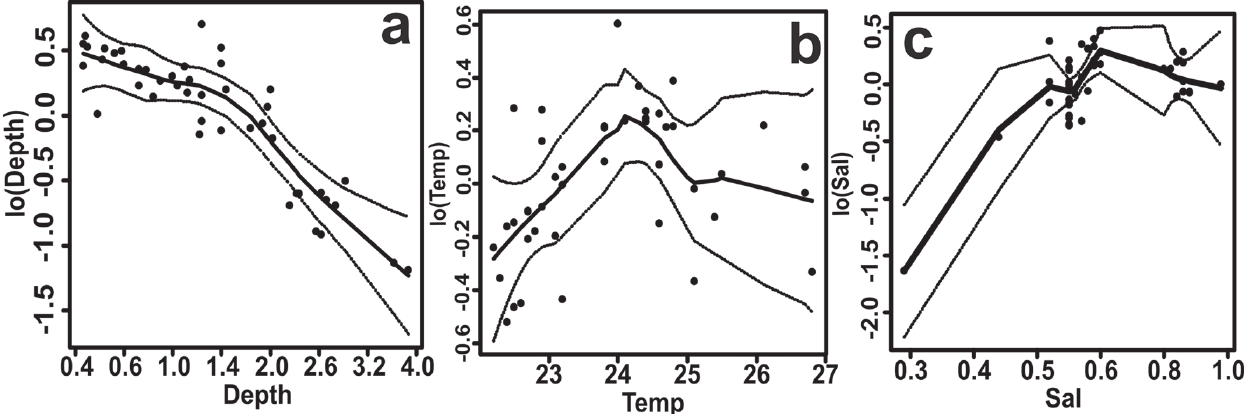
Fig. 2. GAM results for May of environmental characteristics influence on fish density. a: effect of depth (m) on Chirostoma jordani ; b: effect of temperature (°C) on C. jordani ; c: effect of salinity on C. consocium . Circles represent the residuals. Spline fit (solid line) is bound by 95% confidence intervals (dotted